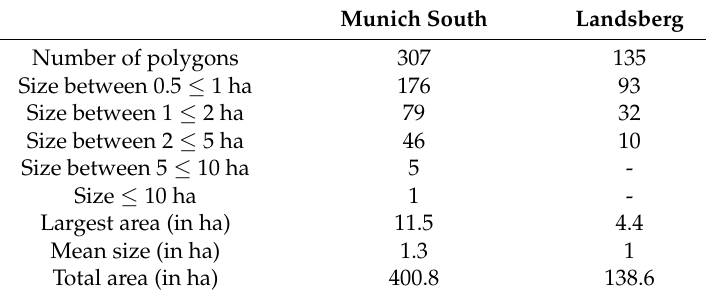
Table 4. Number of reference polygons ( ≥ 0.5 ha) obtained from orthophoto interpretation. The size distribution of the affected windthrow areas is